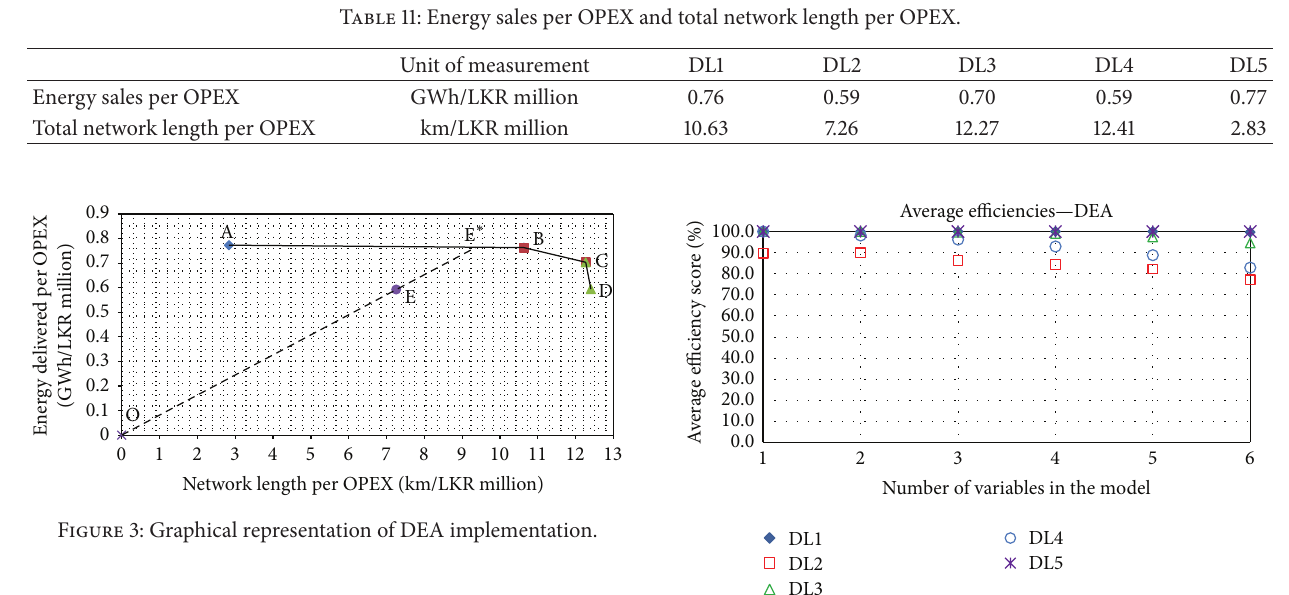
Figure 4: Increase of discrimination with reduction of variables in